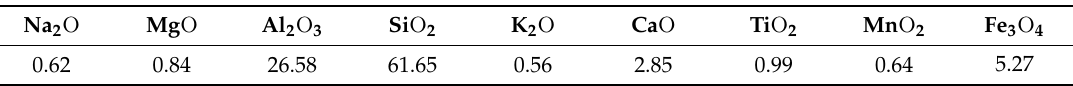
Table 1. Chemical composition (wt %) of raw coal fly ash (CFA) from the Omsk thermal power station No. 4